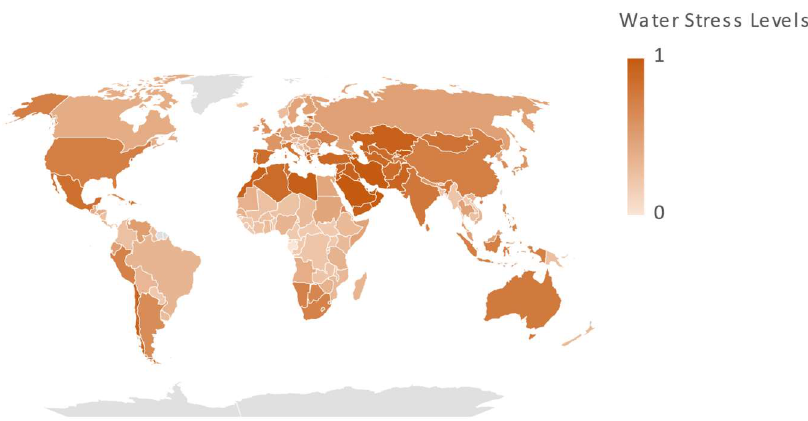
Figure 1. Baseline water stress score worldwide in 2020 (data source: Statista